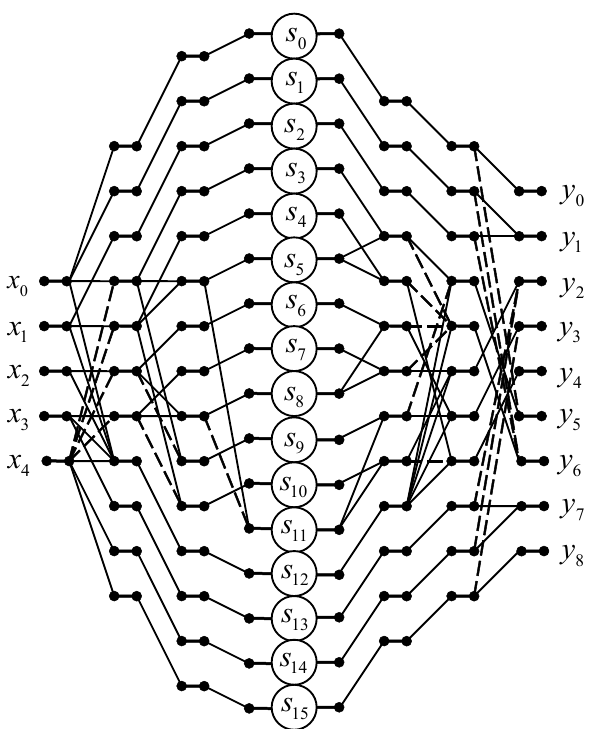
Figure 4. The signal flow graph of the proposed algorithm for computation of 5-point linear